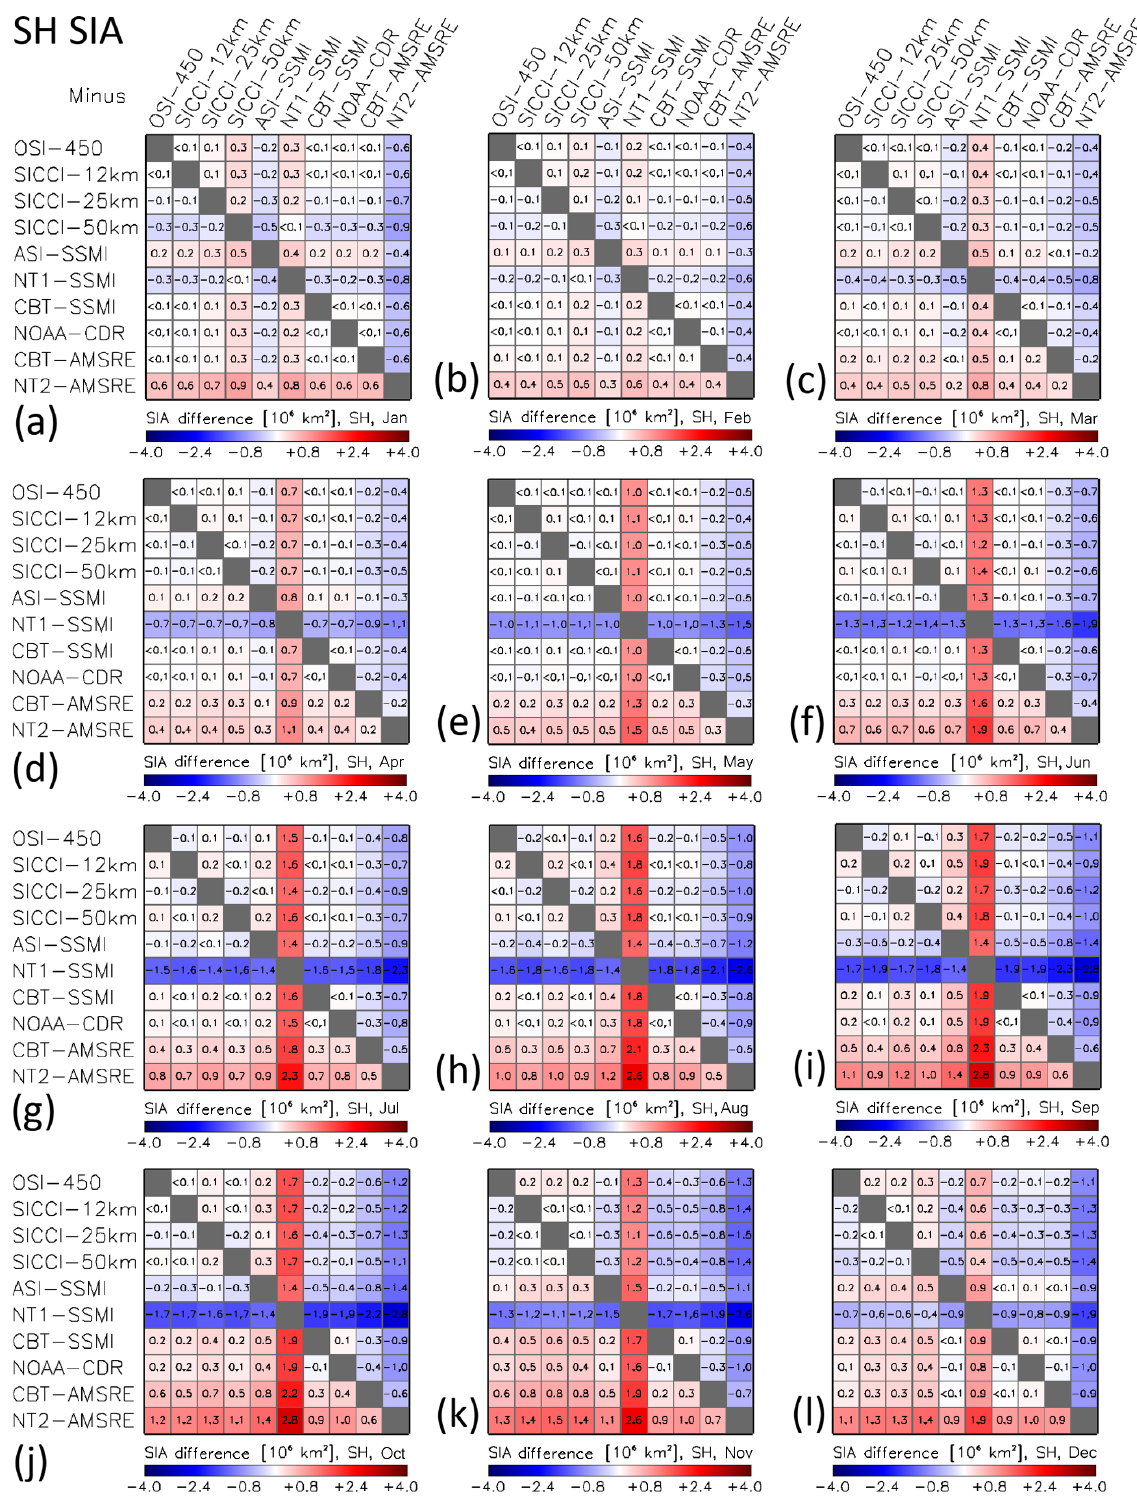
Figure G5. As Fig. G2 but for the Antarctic. Note the larger range of the SIA differences compared to the Arctic.